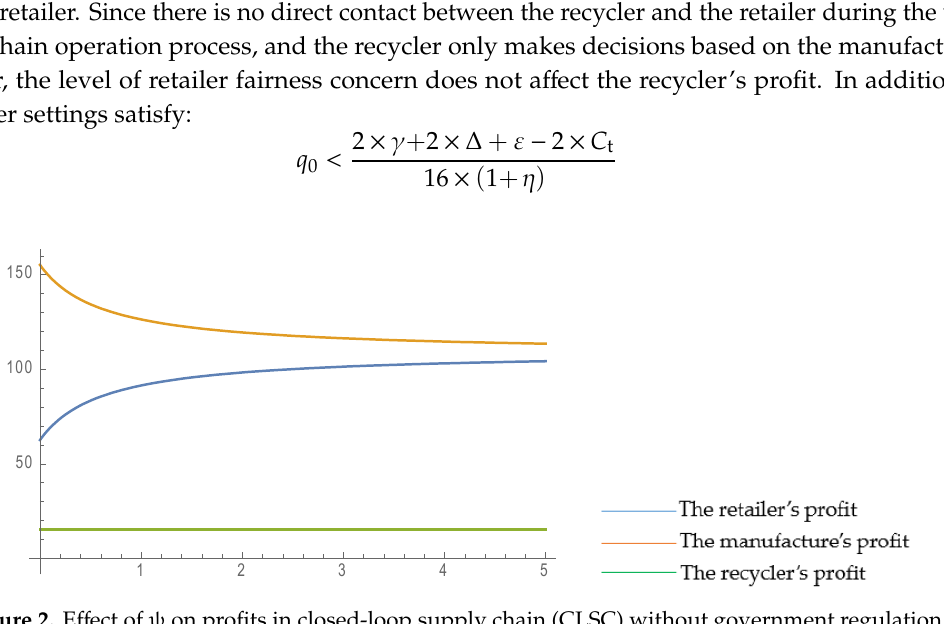
Figure 2. E ff ect of ψ on profits in closed-loop supply chain (CLSC) without government Figure 2. Effect of  on profits in closed-loop supply chain (CLSC) without government regulation